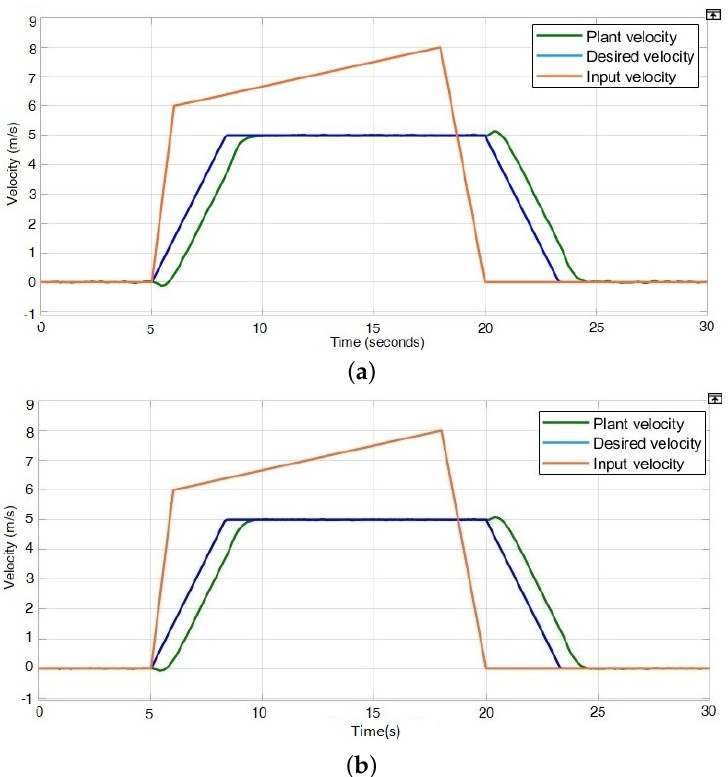
Figure 16. Velocity response of the system at different masses. ( a ) Weight = 30 kg. ( b ) Weight = 180